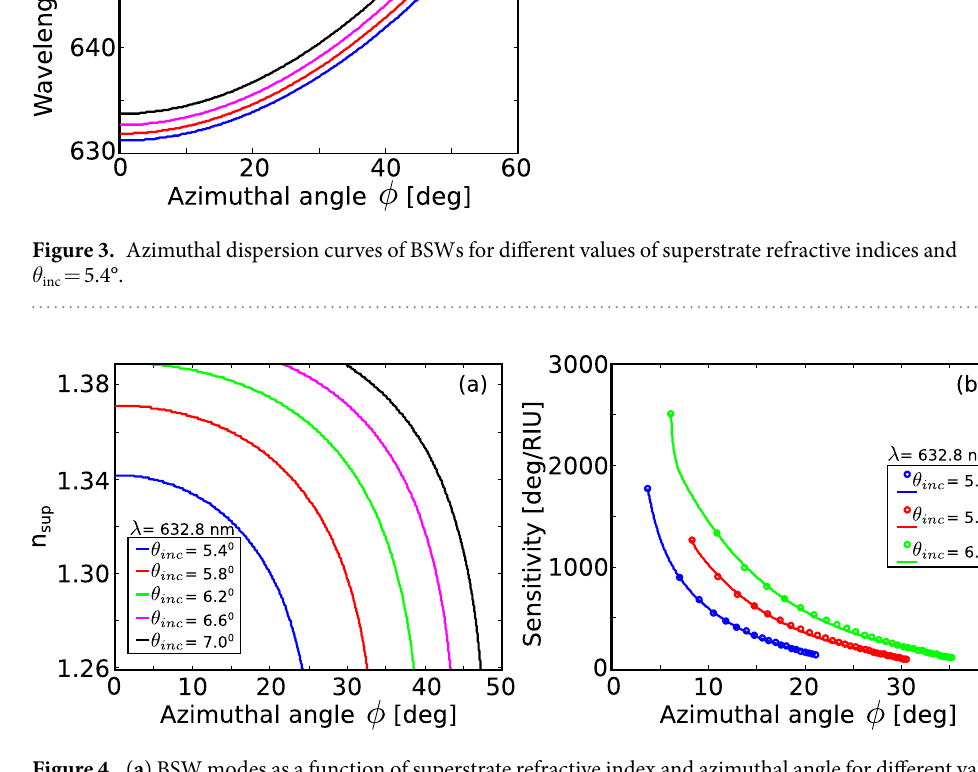
Figure 4. ( a ) BSW modes as a function of superstrate refractive index and azimuthal angle for different values of θ inc at λ = 632.8 nm. ( b ) Azimuthal sensitivity of